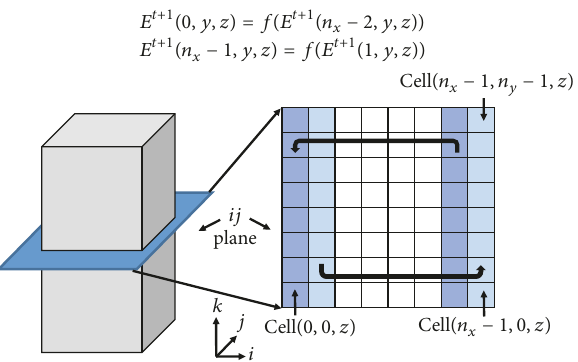
Figure 5: Data dependency on the boundaries.